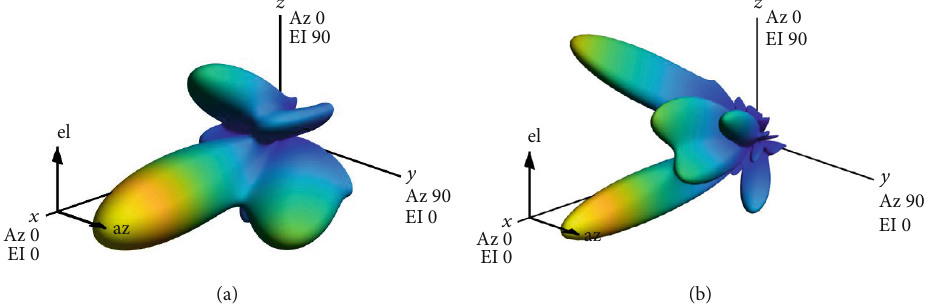
M T = 8 and R = 2 for the MIMO rate-2 mode; (b)